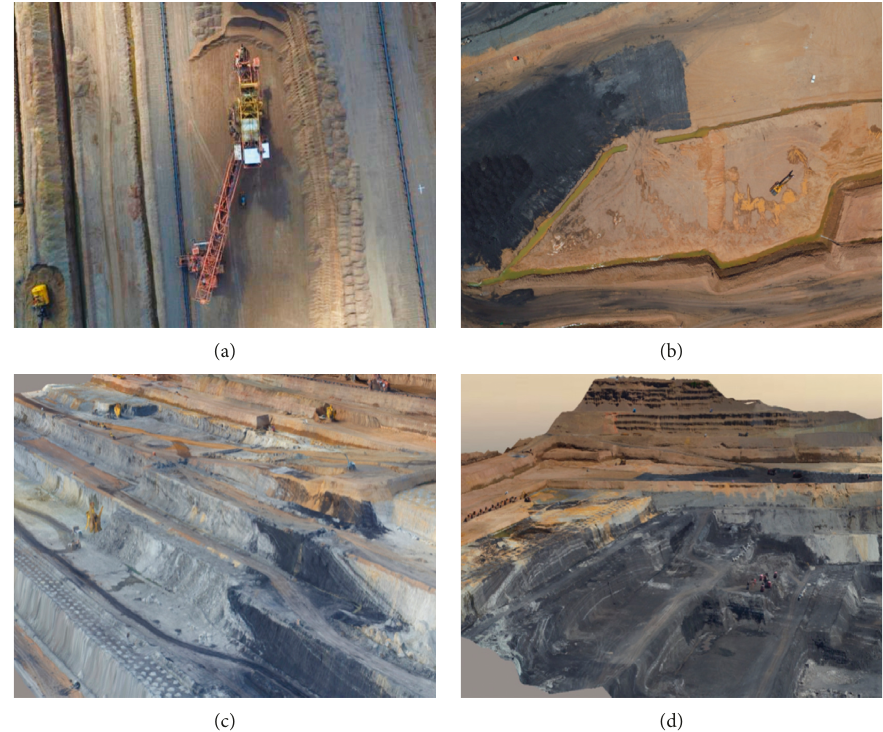
Figure 4: Aerial survey achievements of unmanned aerial vehicles. (a) Top view of the working area of the bucket-wheel excavator. (b) Top view of the eastern area of the working slope. (c) Three-dimensional model of the surface local area in the middle part of the working slope. (d) Three-dimensional surface model of the eastern area of the working